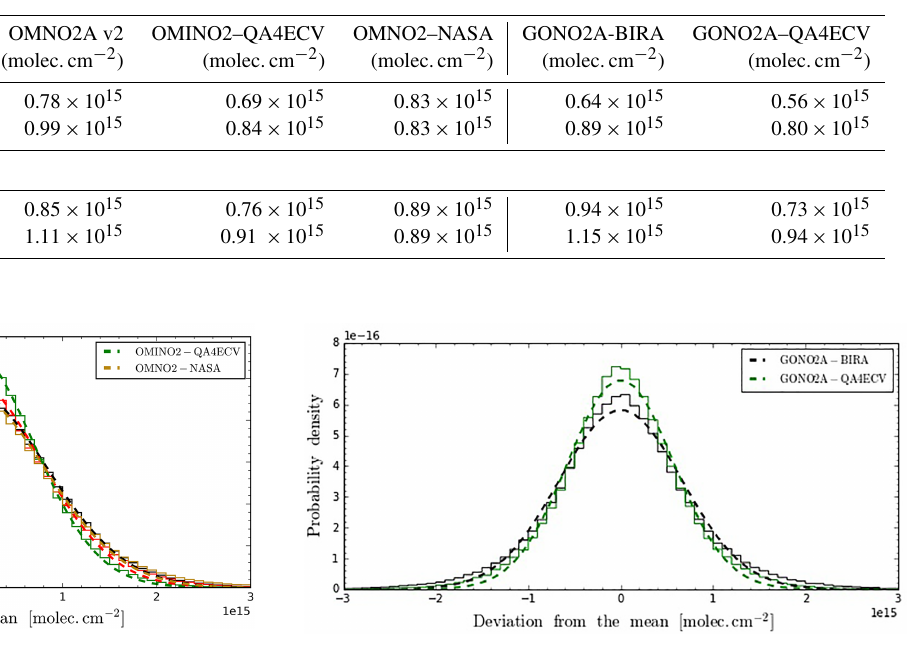
Figure 5. Distribution of the deviation of the SCDs from the mean SCD within a box (for all boxes) in a histogram for GONO2A–QA4ECV (green) algorithm against the reference GONO2A-BIRA (black). The width, σ , of the Gaussian pro- vides an estimate of the SCD uncertainty for each SCD retrieval algorithm ( σ bira = 0 . 635 ± 0 . 008 × 10 15 molec.cm − 2 , σ qa4ecv = 0 . 556 ± 0 . 006 × 10 15 molec.cm − 2 ) . The histogram contains con- tributions from all boxes within the reference sector for the Pacific orbit from day 1 of January, April, July, and October 2007–2015. No cloud screening has been